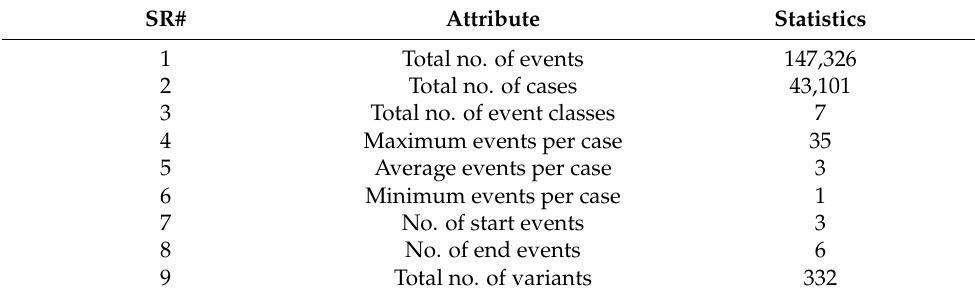
Table 4. Statistics of log data after removing missing